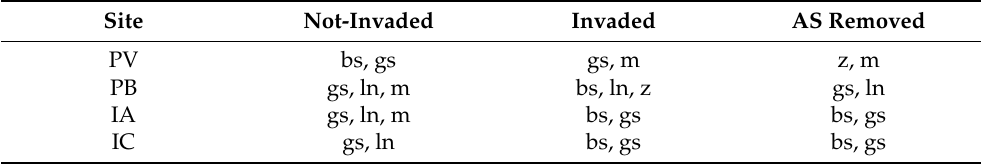
Table 1. Models of rank abundance by site and situation with and without nonnative species (NIS) retained with better adjustments based on the lowest AIC criteria and Δ AIC ≤ 2. Bs = Broken-stick;